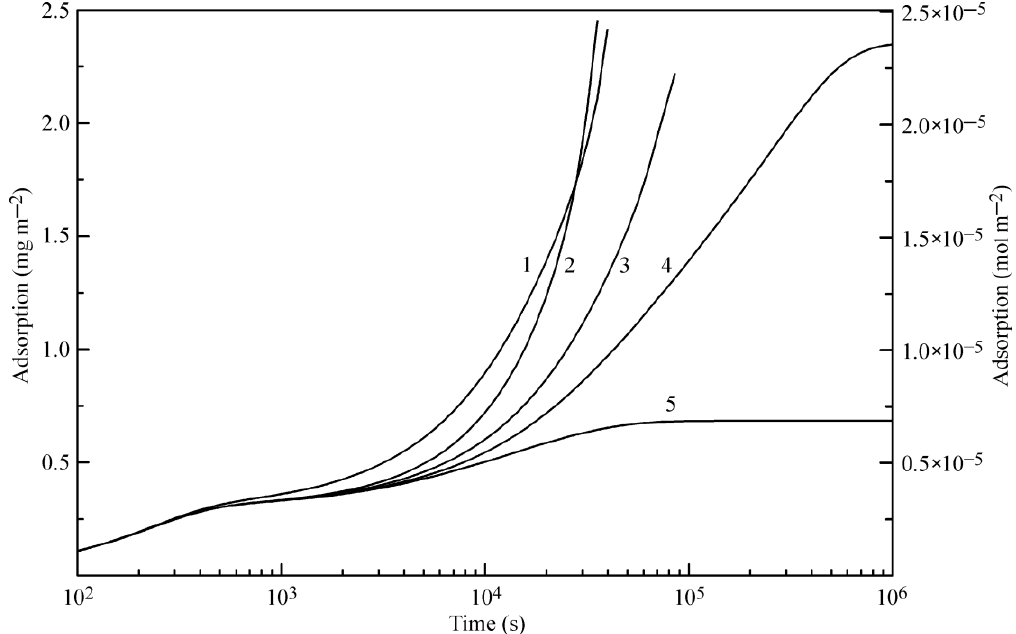
Figure 7. Influence of certain model parameters on the adsorption kinetics. For details, see text.